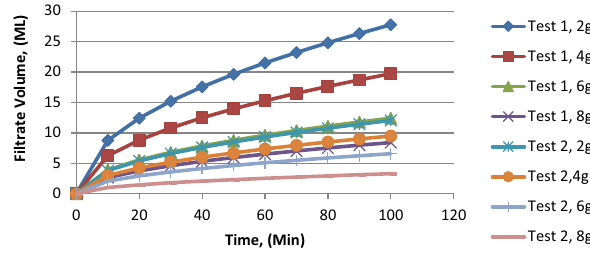
Fig. 5 Filtrate volume results for the effect of Cyperus esculentus concentration